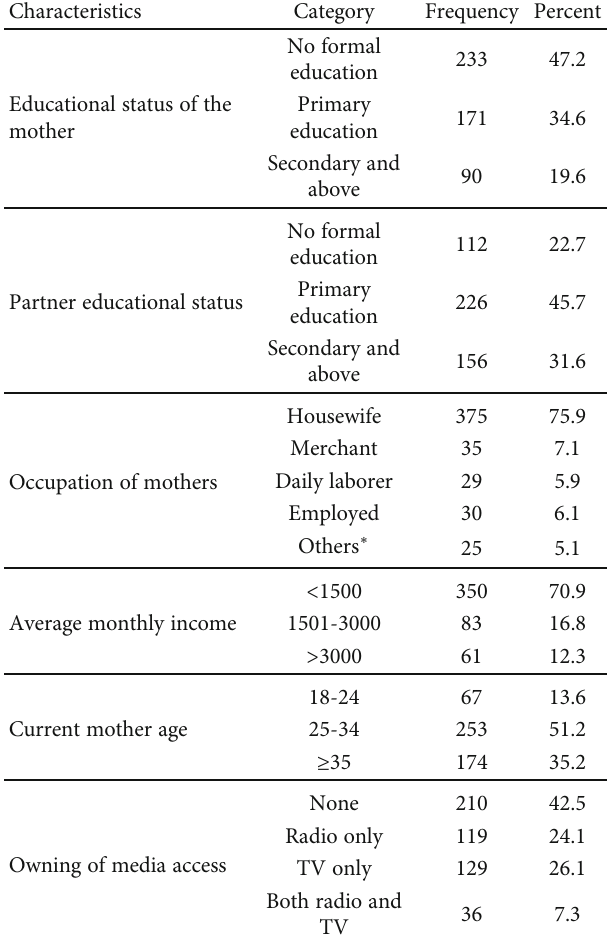
Table 1: Sociodemographic characteristics of married reproductive- age women, Toke Kutaye district, West Shoa, Oromia, Ethiopia, March 2019 ( n = 494 ).